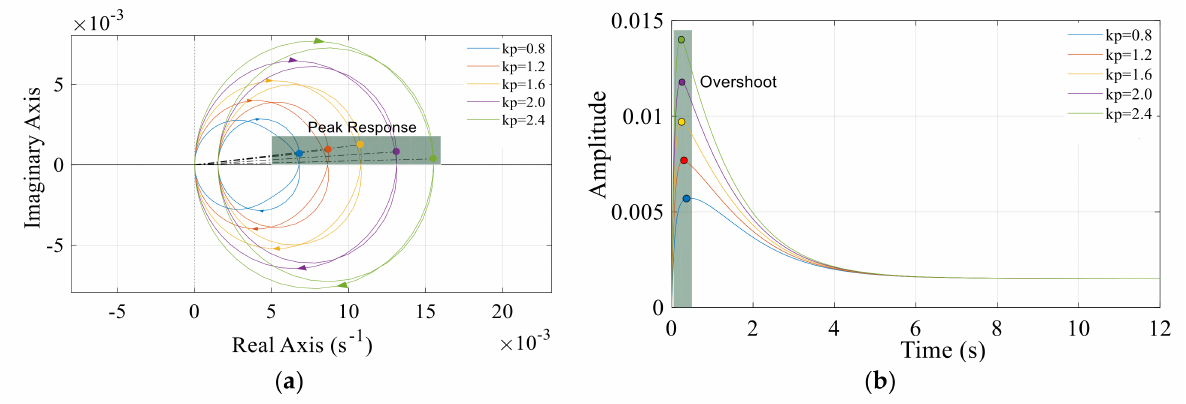
Figure 13. Nyquist and step responses to the variation of the proportional adjustment coefficient, k p = [0.8, 2.4]. ( a ) Nyquist response, and ( b ) step